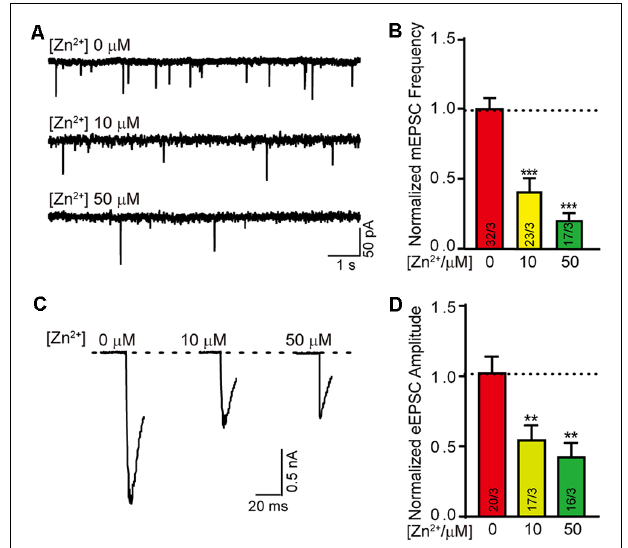
FIGURE 2 | Higher concentration of Zn 2+ damages the excitatory synaptic transmission. (A) Sample traces of mEPSCs recorded in cortical neurons cultured with 0 µ M/10 µ M/50 µ M Zn 2+ . (B) Summary graphs of the normalized frequency of mEPSCs for all conditions as described for (A) . (C) Sample trace of action potential eEPSCs recorded from cortical neurons cultured with 0 µ M/10 µ M/50 µ M Zn 2+ . (D) Summary graphs of the normalized amplitude of eEPSCs recorded in the neurons described in panel (C) . Data information: numbers of cells/independent cultures analyzed are listed in the bars. Data shown in summary graphs are mean values ± SEM. Statistical significance was analyzed by Student’s t -test. ** p < 0.01; *** p <